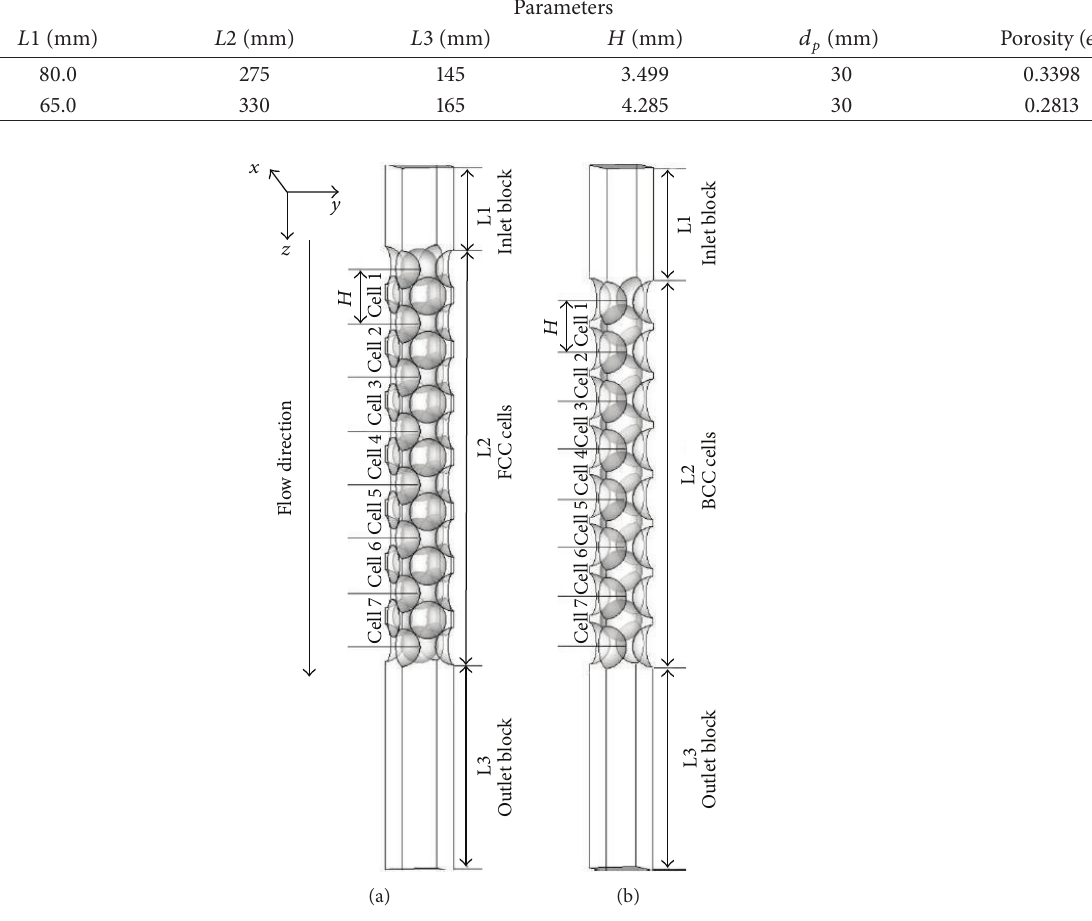
Figure 1: BCC (b) and FCC (a) packed cells with extend inlet and outlet